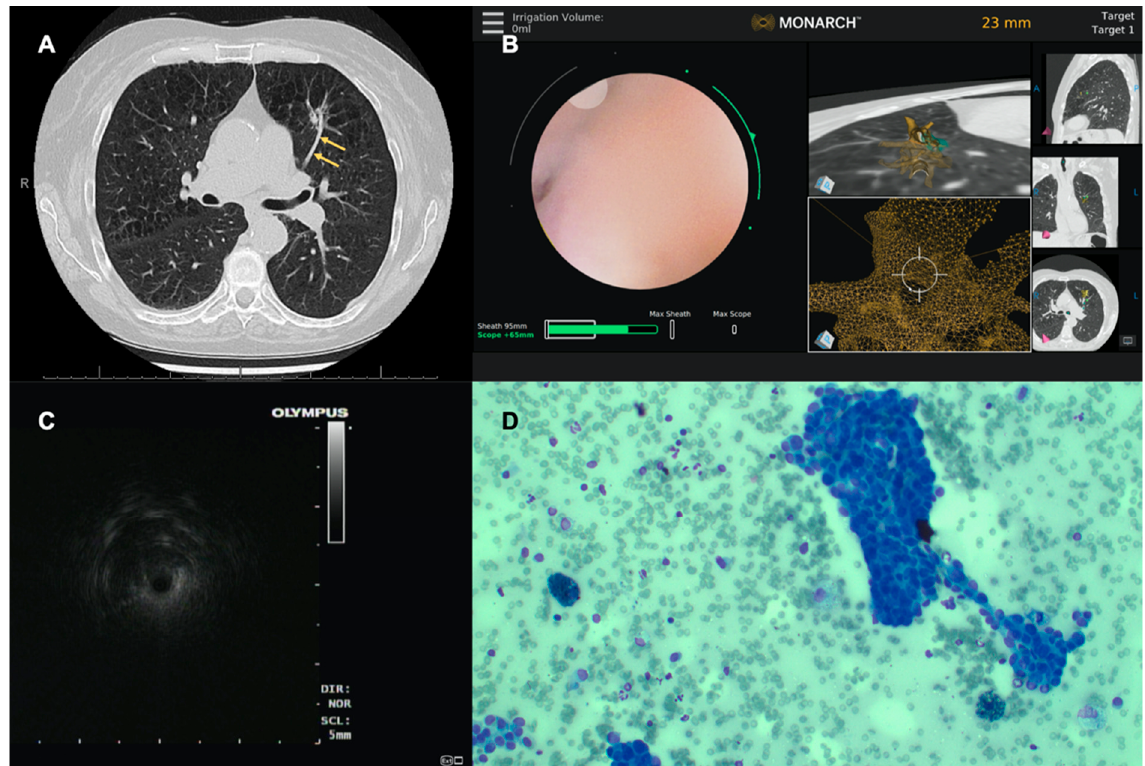
Figure 2. CT image in the axial plane showing the absence of an airway, but presence of a vessel (yellow arrows) leading to the target lesion in the left lower lobe ( A ). Successful mapping of a pathway to the target lesion using the “artery sign” on the on the Medtronic superDimension™ electromagnetic navigation bronchoscopy platform during pre-procedural planning ( B ).